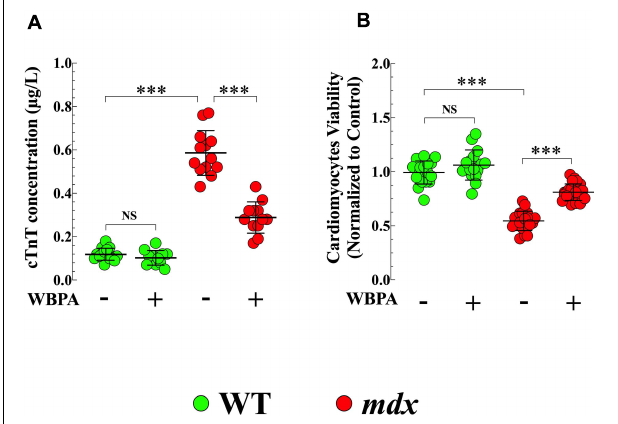
FIGURE 4 | Whole body periodic acceleration reduced cTnT plasma level and increased cell viability. Measurements cTnT plasma level (A) , and cardiomyocyte viability (B) were evaluated in 15-month WBPA-treated and untreated WT and mdx dystrophin-deficient mice. cTnT plasma level was 4.9-fold more elevated (A) in mdx than WT cardiomyocytes. Furthermore, mdx cardiomyocytes showed a reduction in cell viability by 1.7-fold compared to WT cardiomyocytes (B) . WBPA lower cTnT plasma level by 2-fold (A) , and increased cell viability by 1.4 compared to WBPA-untreated mdx (B) . No effect of WBPA on cTnT release and cell viability was observed in WT cardiomyocytes (A,B) . cTnT plasma level : Untreated and WBPA-treated WT, N = 5 mice per experimental conditions , n = 15–12, respectively; Untreated and WBPA-treated mdx N = 5 mice, per experimental conditions n = 13–12, respectively. Cell viability : Untreated and WBPA-treated WT, N = 3 mice per experimental conditions , n = 18–16, respectively; Untreated and WBPA-treated mdx N = 5 mice, n = 20–24, respectively. Values are expressed as means ± S.D. One-way ANOVA with Tukey’s post-test, *** p ≤